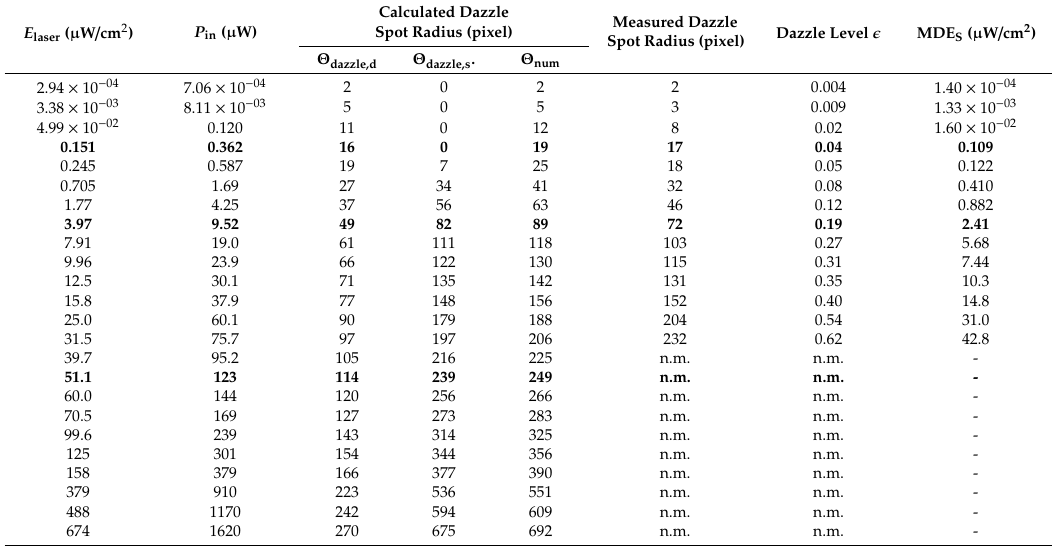
Table A2. Calculated and measured dazzle spot size using Setup 1 (see Section 6.2) for a laser wavelength of 488 nm. Abbreviation: n.m.: not